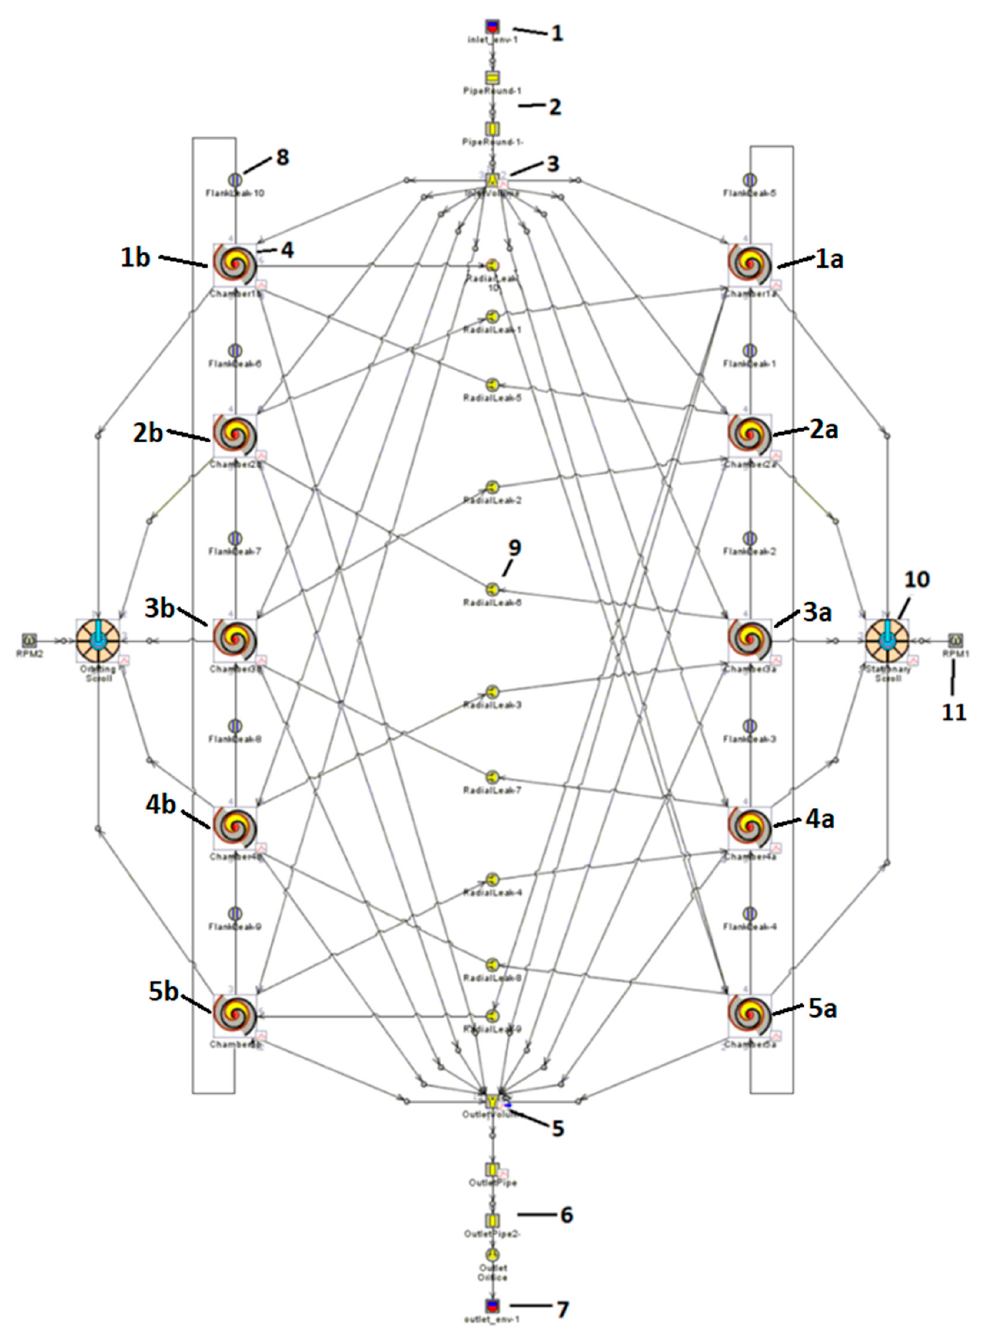
Figure 3. Numerical model of the scroll expander in the GT-SUITE TM . The model block diagram considers two leakage flow paths between adjacent chambers, i.e., flank leakage and radial leakage.